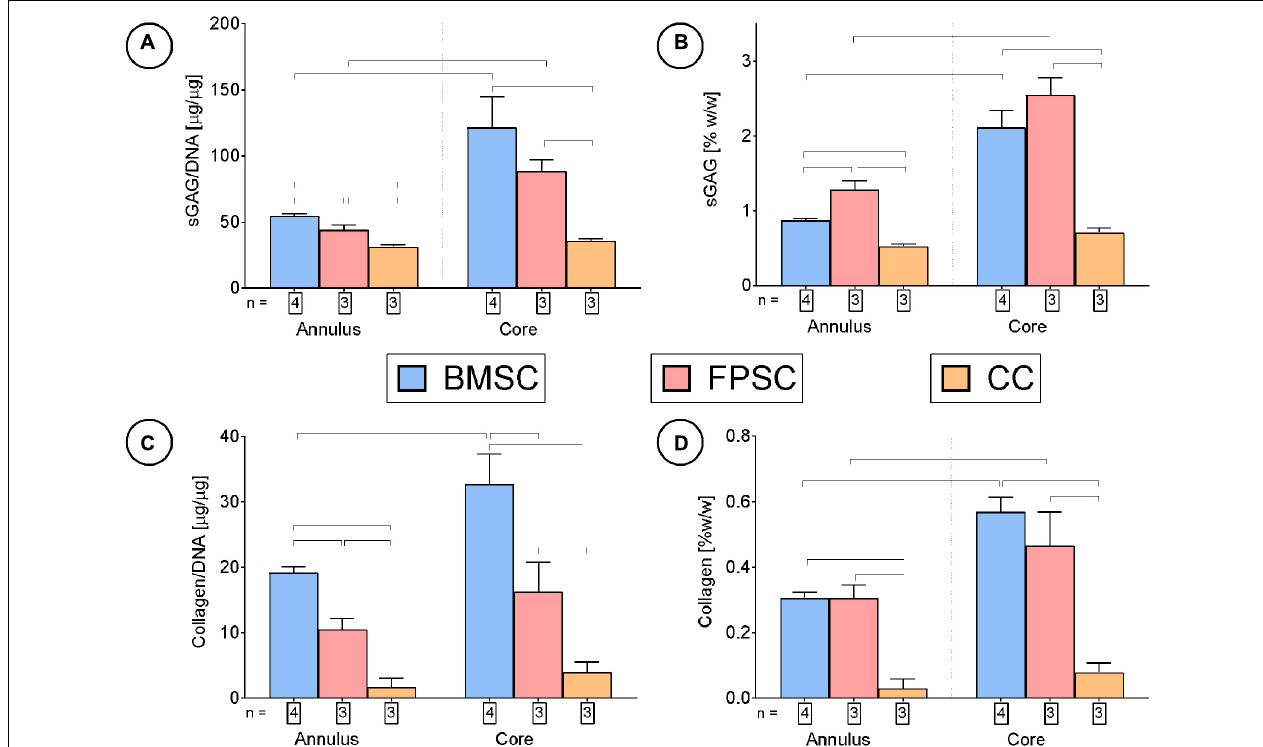
FIGURE 4 | Cartilage tissue grafts engineered using various cell sources were cultured for for 24 days, then subsequently separated into cores and annuli and analyzed for DNA, sGAG and collagen content. Significant differences between groups are indicated where P < 0.05 (n shown on